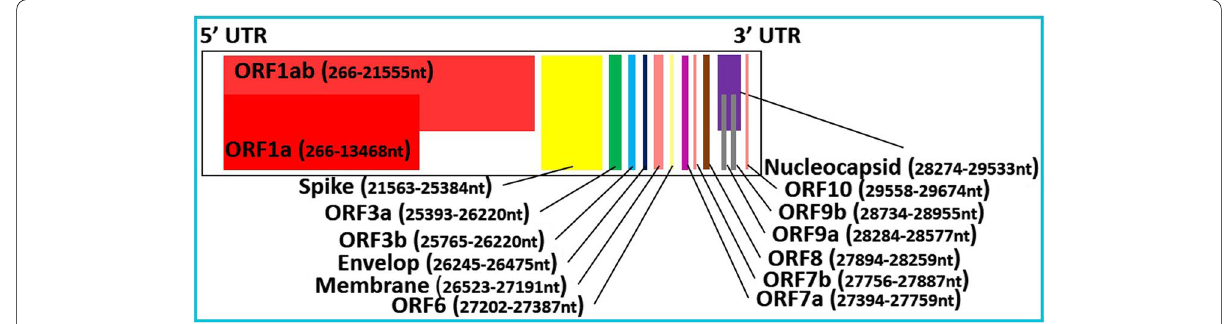
Fig. 1 Genome structure of SARS-CoV-2. The genome of SARS-CoV2 comprises of 5 ′ and 3 ′ untranslated region (UTR) and several open reading frames (ORFs) comprising of non-structural and structural proteins including spike, envelop, membrane, and